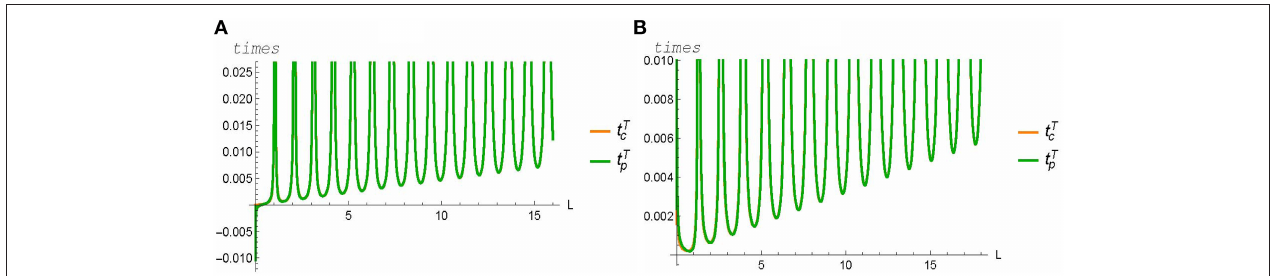
FIGURE 3 | Tunneling times for odd arrangements of two point interactions (in atomic Rydberg units). (A) Double- δ , with γ with γ 60 and k 1.2 . In both cases t p = =